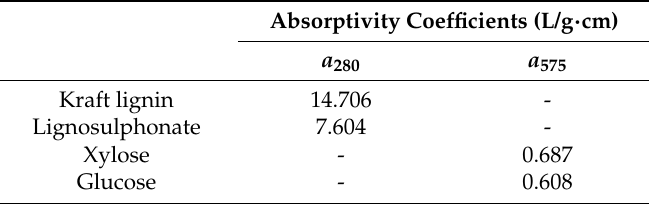
Table 1. The absorptivity coefficients for determination by UV-VIS spectrophotometry of the concentration of the different tested